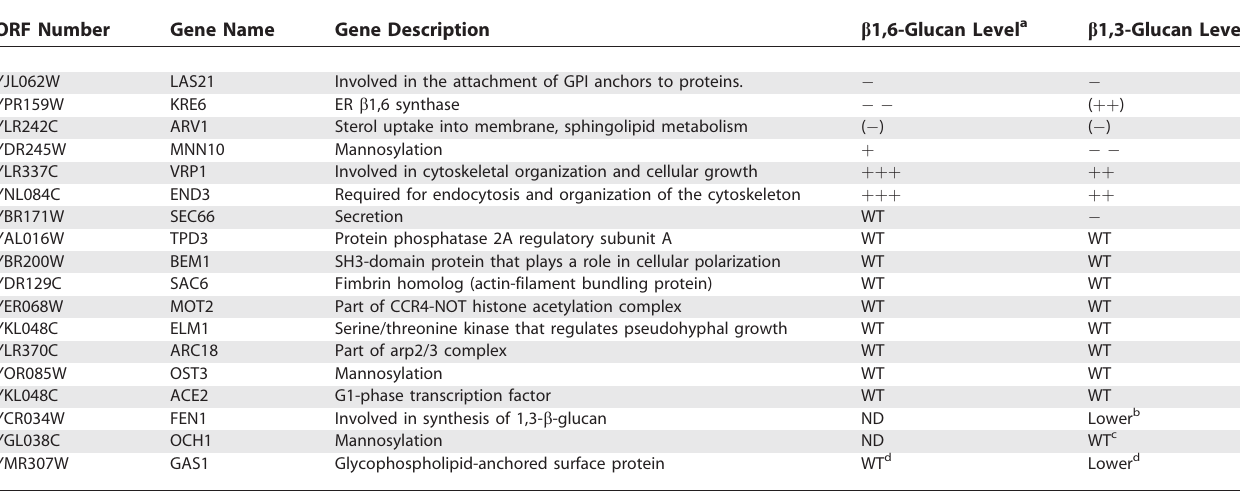
Table 1. b -Glucan Exposure Does Not Correlate with Bulk Level in S. cerevisiae Mutants ORF